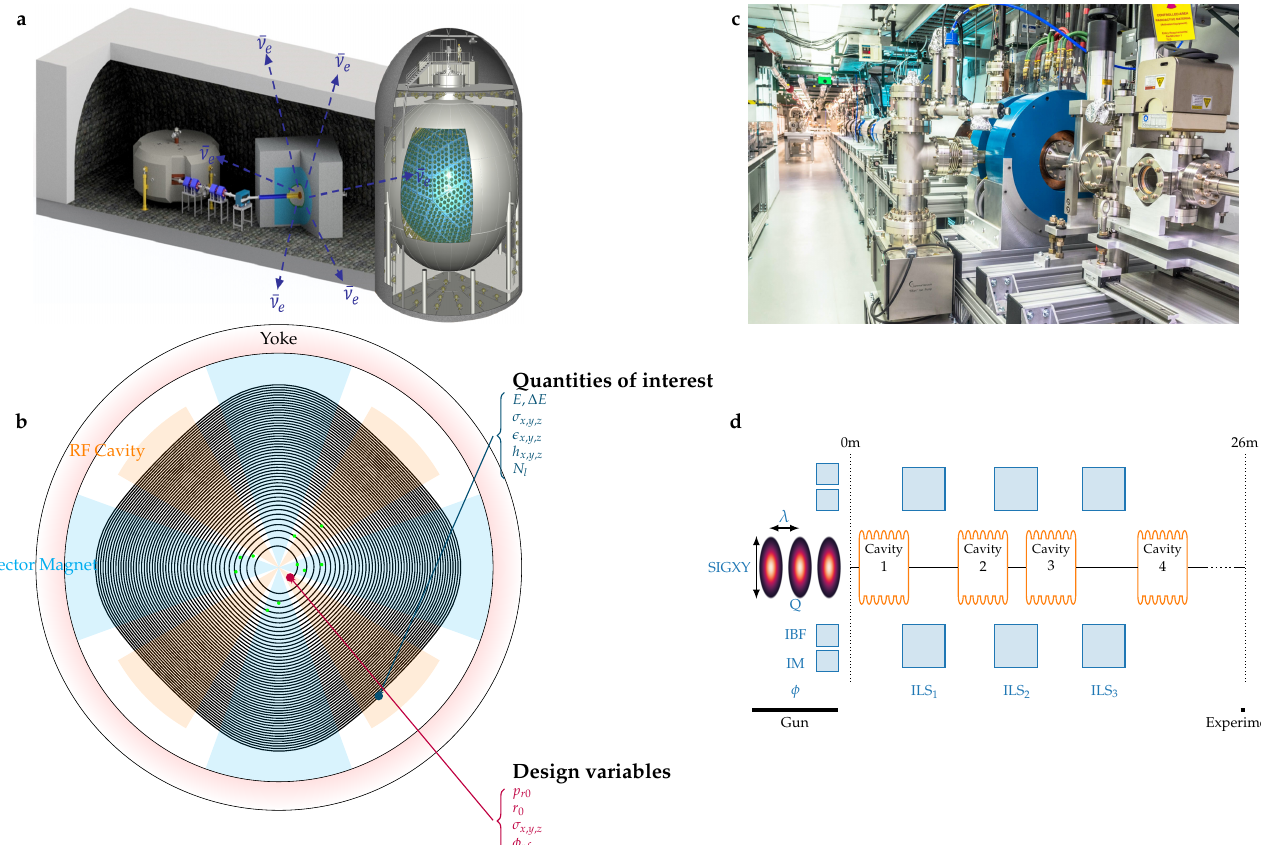
Figure 1. Overview of the use cases. ( a ) Artistic representation of the IsoDAR experiment at KamLAND (Kamioka Observatory, Japan), from left to right the cyclotron, target and detector are depicted. ( b ) A schematic of the IsoDAR cyclotron with the relevant parameters. ( c ) The AWA facility at Argonne National Laboratory (US), pictured from the gun downstream (courtesy of J. Power). ( d ) Schematic of the relevant parts of the AWA